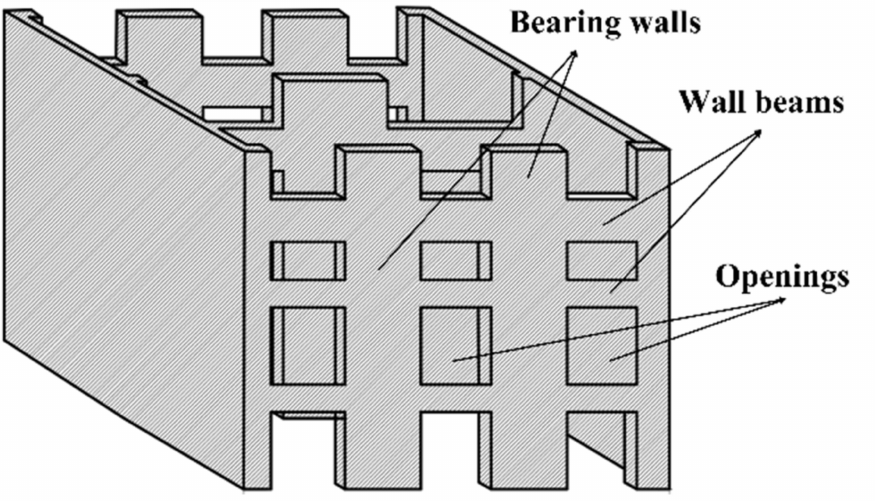
Figure 1. An example frame of WRC structures.